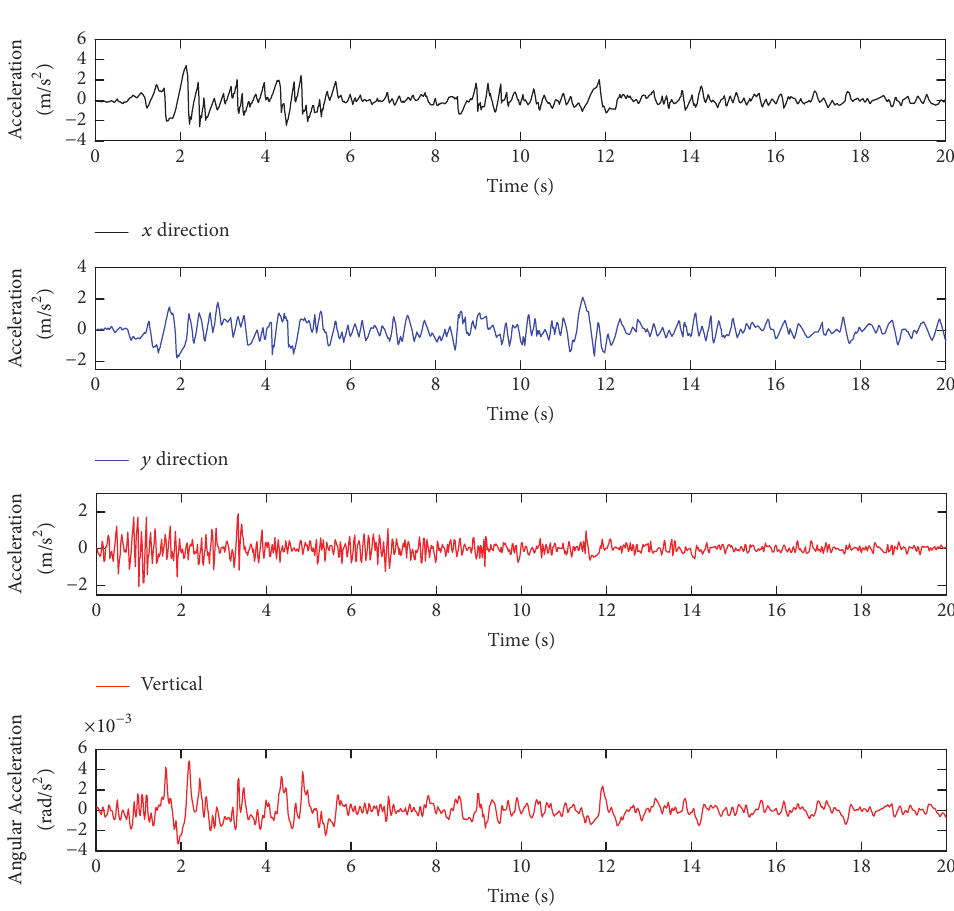
Figure 5: El Centro earthquake waves in different